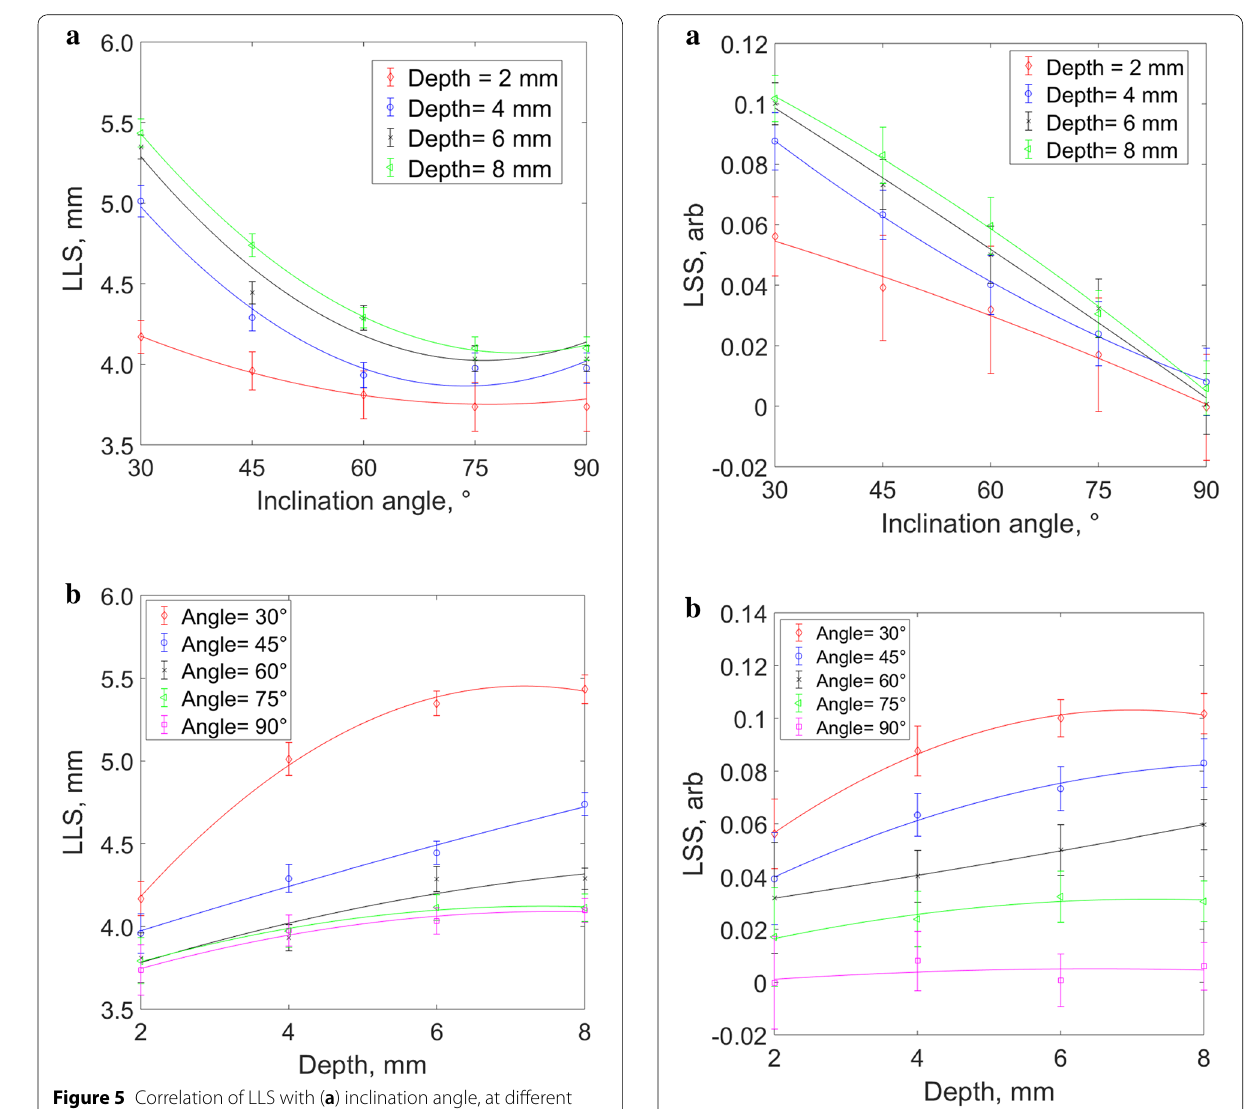
The LS max was proven to be less affected by the inclina- tion angle, which served as a good feature for depth approximation. Meanwhile, the linear correlation of the LLS and the LSS is useful for inclination angle